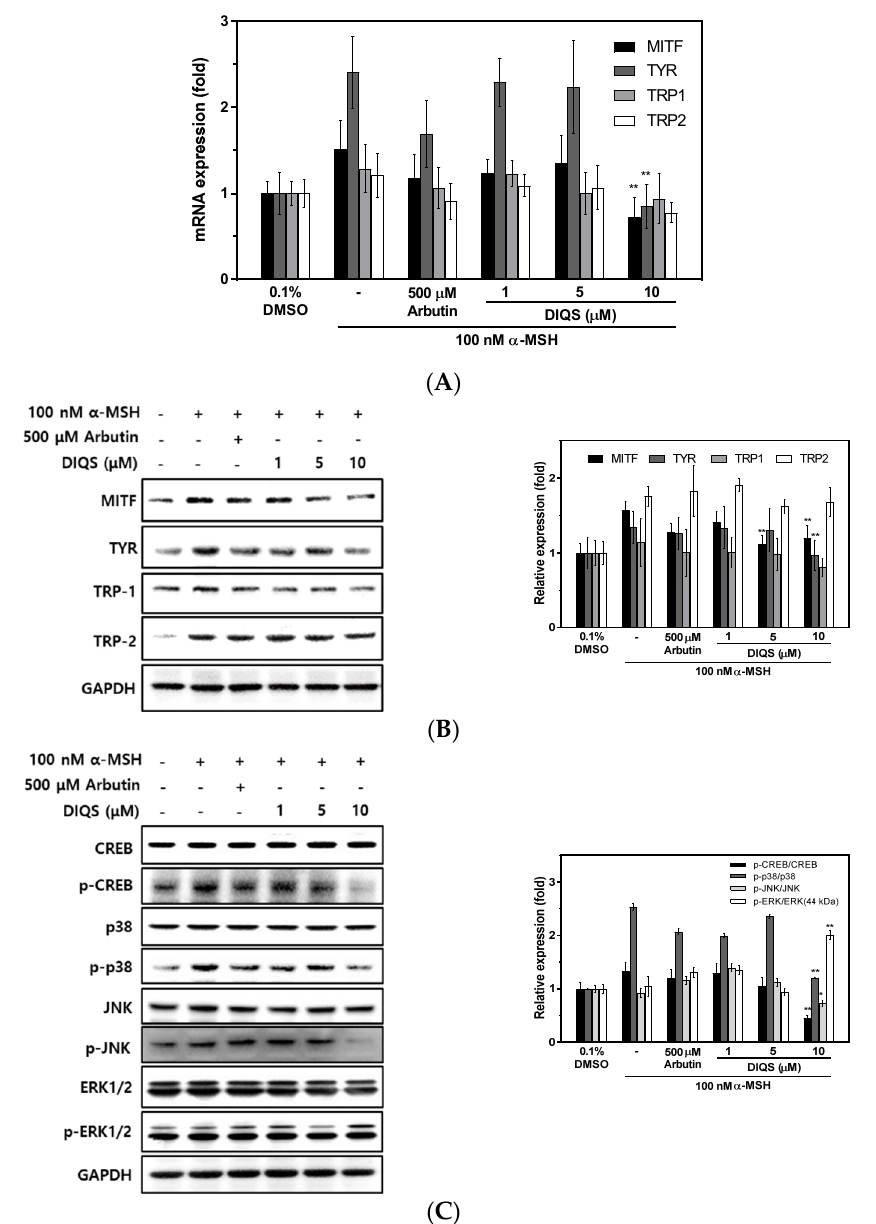
Figure 2. DIQS affected the expression of melanogenesis-related proteins and upstream signaling pathways. ( A ) B16F10 cells were incubated with the indicated concentrations of DIQS for 48 h. mRNA levels of the melanogenesis-related genes MITF , tyrosinase, TRP-1 , and TRP-2 were determined by qRT-PCR. The results are expressed relative to untreated cells after normalization against the GAPDH level. ( B ) B16F10 cells were incubated with the indicated concentrations of DIQS for 48 h. Arbutin was used as a positive control. The protein levels of MITF, tyrosinase, TRP-1, and TRP-2 were determined by Western blot analysis. ( C ) Phosphorylation levels of CREB and MAPKs were also determined by Western blot analysis. The phosphorylation level of each MAPK is expressed relative to the respective total protein level. Protein levels were quantified using myImageAnalysis v2.0 software. Data are means ± SD. * p < 0.05 and ** p < 0.01 (vs. the α -MSH-treated group).